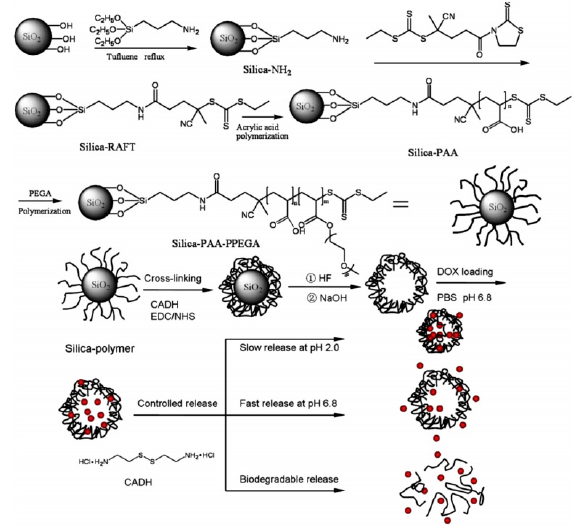
Figure 11. The preparation of pH responsive, biodegradable, biocompatible and cross-linked polymer capsules for controlled drug DOX (the red dots) release. Copyright 2014, Elsevier.